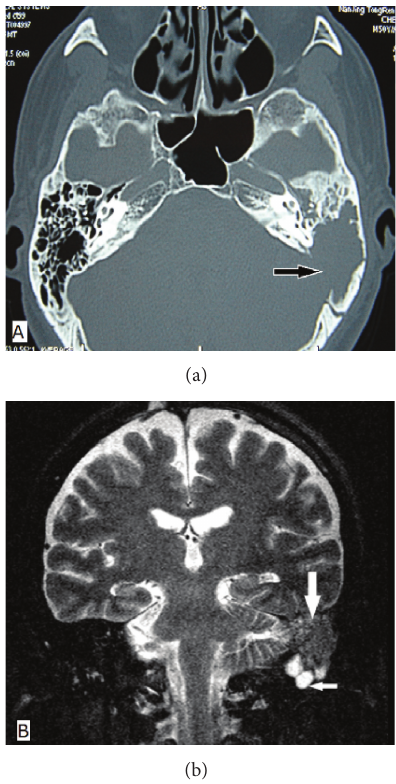
F 1: Imaging �ndings of Case 1. (a) Axial CT of the temporal bone shows a so-tissue mass in the le middle ear and mastoid cavity with extension into the sigmoid sinus plate (arrow); (b) coronal MRI shows a slightly low-signal-intensity mass on T2- weighted images in the le mastoid (large arrow). Several inferior